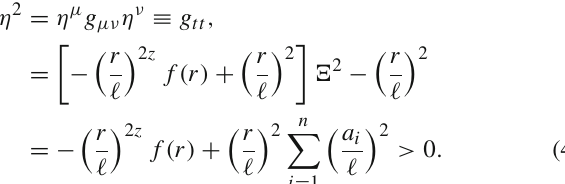
Another issue that arises within this metric is related to the rotation Killing fields m i . There are n independent rotation ≡ m μ ∂ μ , i = 1 . . . n , which is cyclic field m i = ∂ φ i i